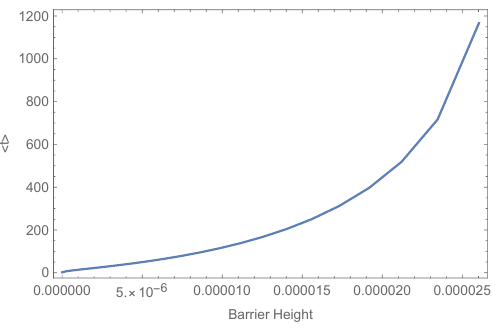
Figure 10 . The correlation between the mean kinetic time h t i and the barrier height for the phase transition process from the stable wormhole phase to the unstable wormhole